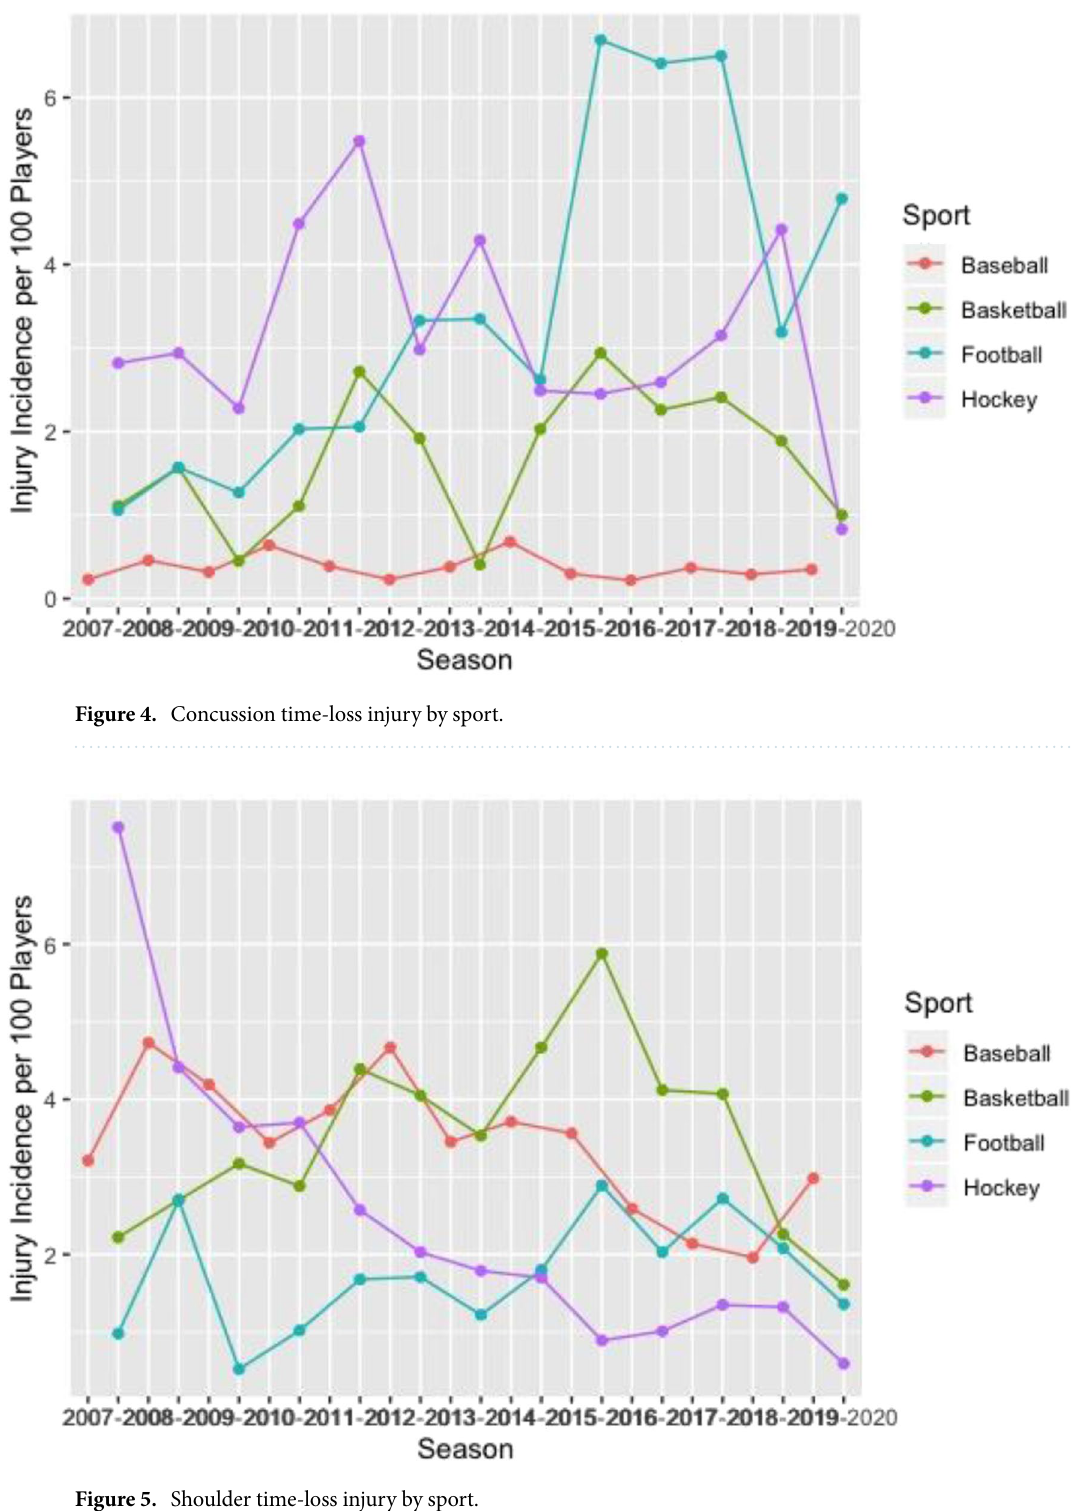
Figure 5. Shoulder time-loss injury by